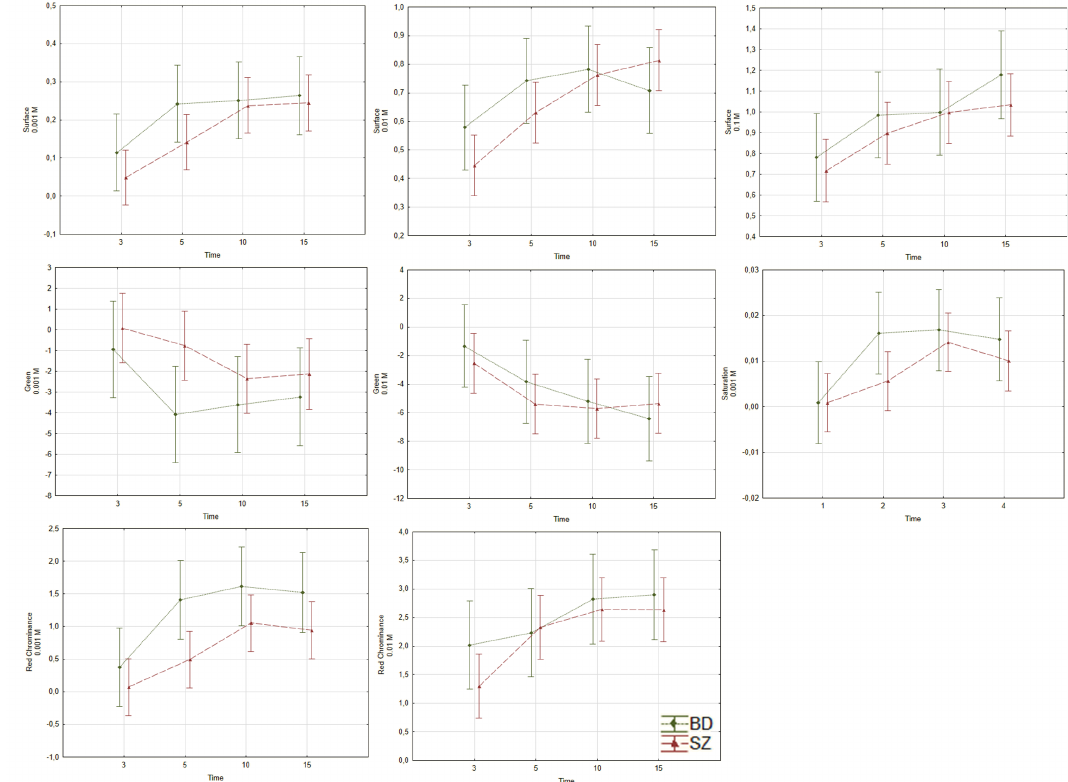
Figure 3. Di ff erences in response to niacin solution between SZ and BD. The red line—SZ group, the green line—BD group, the vertical axis—skin color, the horizontal axis—time of measurement in minutes. Diagrams represent group and within-subjects e ff ects described in Section 3.1.2. SZ—schizophrenia; BD—bipolardisorder. ( a )surface, 0.001M;( b )surface, 0.01M;( c )surface, 0.1M;( d )greencolour, 0.001M; ( e ) green colour, 0.01 M; ( f ) saturation, 0.001 M; ( g ) red chrominance, ( h ) 0.001 M; red chrominance, 0.01